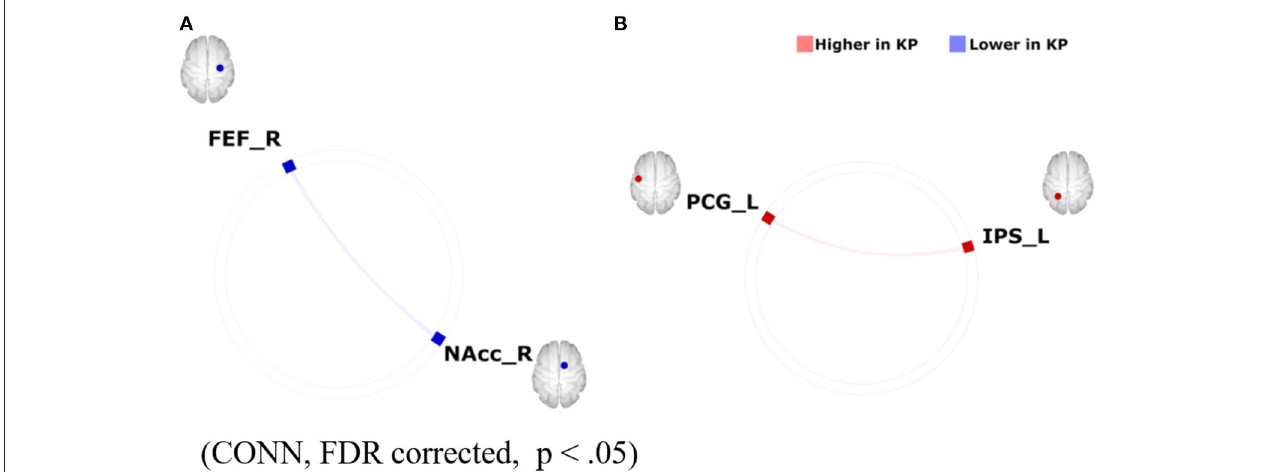
FIGURE 6 | Group differences in FC within the motivation network on (A) resting-state-functional magnetic resonance imaging (rs-fMRI) and (B) task-based fMRI during an auditory oddball paradigm (KPs < NKPs/ KPs > NKPs). FEF, frontal eye field; FC, functional connectivity; NAcc, nucleus accumbens; PCG, precentral gyrus; IPS, intraparietal sulcus; L, left; R, right; KP, Kendo players; NKP, Non-kendo players [Revised from Fujiwara et al. (